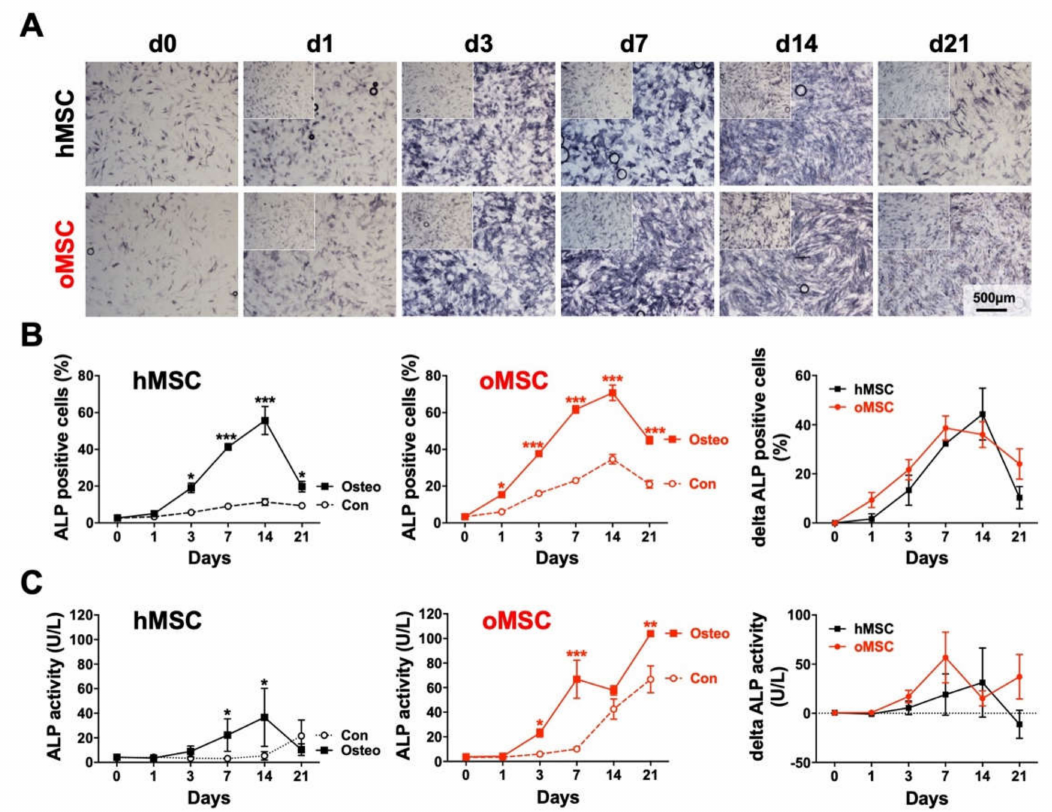
Figure 4. Alkaline Phosphatase (ALP) intensity and activity during the osteogenic di ff erentiation process. ( A ) Mesenchymal stromal cells (MSC) of healthy control donors (hMSC) and osteoporotic donors (oMSC) at passage 3 were induced towards the osteoblast lineage for 21 days, and ALP staining was performed at indicated time points. A culture medium without any osteogenic induction supplement was used as control (inserts in the top left corners). The same magnification was used for all analyses. ( B ) The relative ALP staining intensity of both BMSCs was evaluated by measuring the percentage of cells stained positive using the cellSens Dimension software, and the delta of ALP positive cells was determined by subtracting the non-induced controls from the induced MSCs. ( C ) ALP activity of hMSCs and oMSCs was determined with the help of 4-Methylumbelliferyl phosphate disodium salt substrate using a fluorometric assay at indicated time points. The delta ALP activity was determined by subtracting non-induced from induced MSCs. Data are expressed as average ± SD of three to eight donors per group. * p < 0.05, ** p < 0.01, *** p < 0.001, one-way